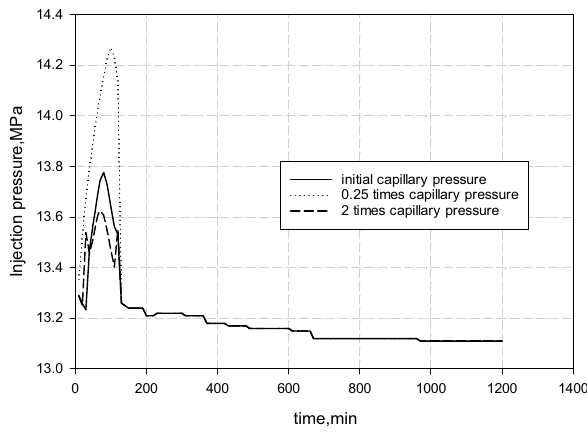
Fig. 7 Injection pressure curve under different capillary pressures